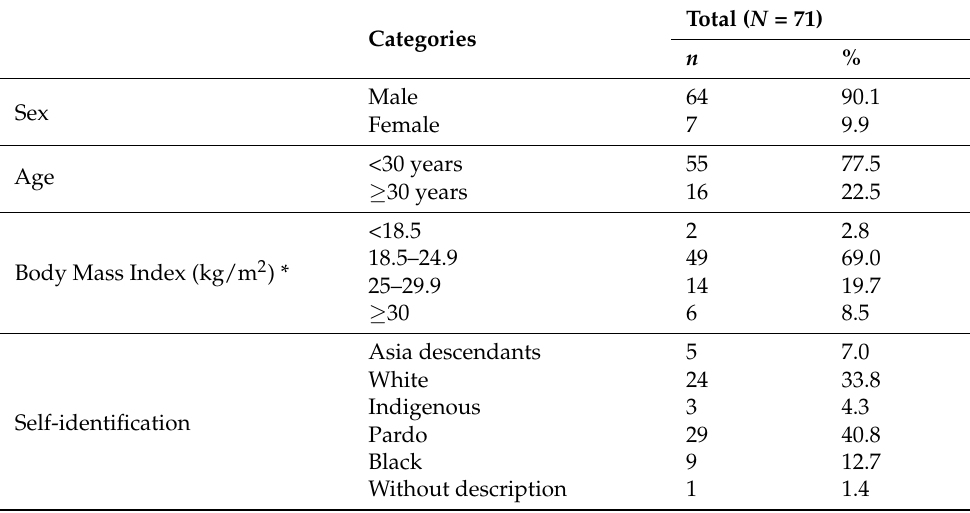
Table 1. Sociodemographic data and sample profile ( n =